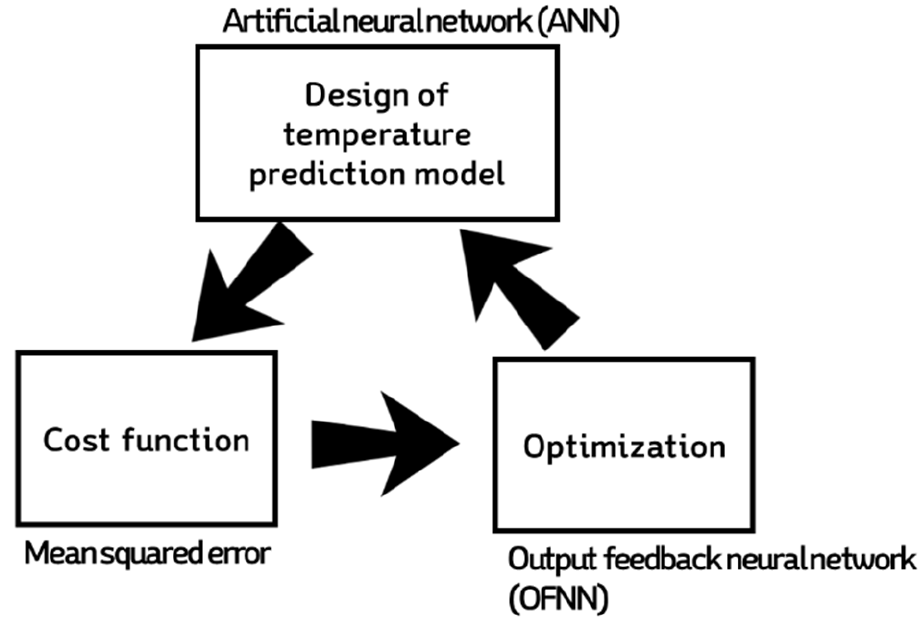
Figure 2. Schematic of the neural-network-based temperature prediction model and optimizer. Table 2. Functions used in the artificial neural network hidden nodes.